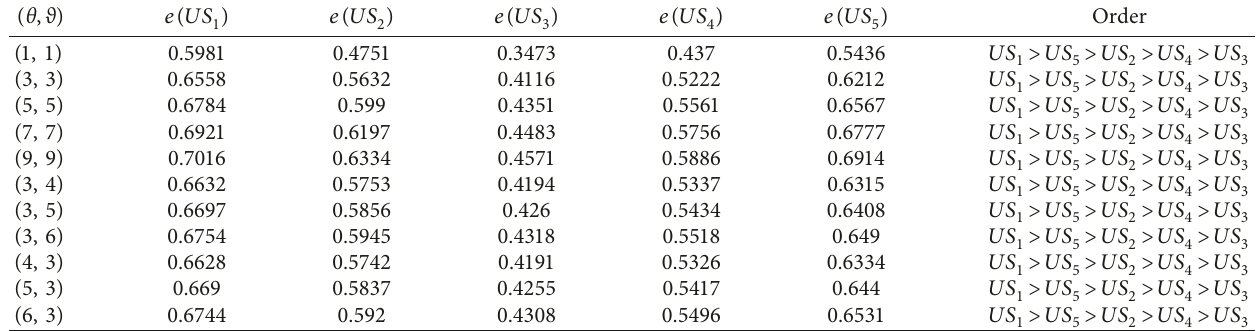
Table 5: Order results for different parameter values of the G2TLNWHM operator.